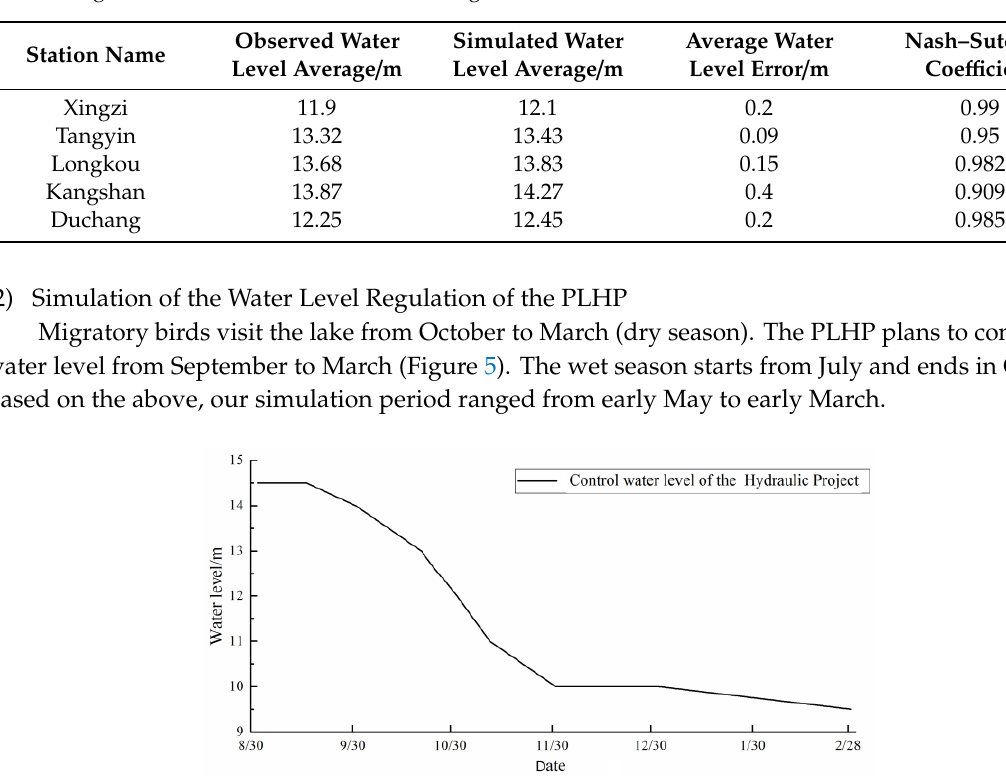
Figure 5. Water-level regulation process in the hydraulic project.